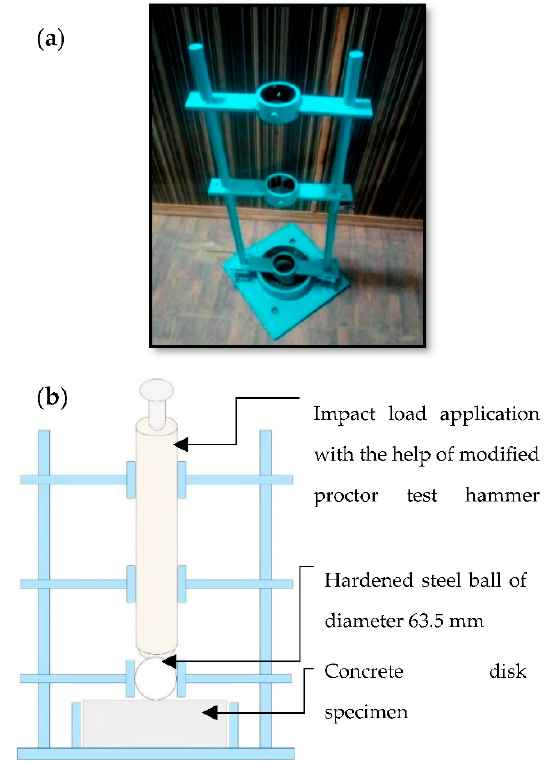
Figure 4. ( a ) Assembly prepared for the performance of drop weight impact test; ( b ) schematic dia- gram of the assembly. diagram of the